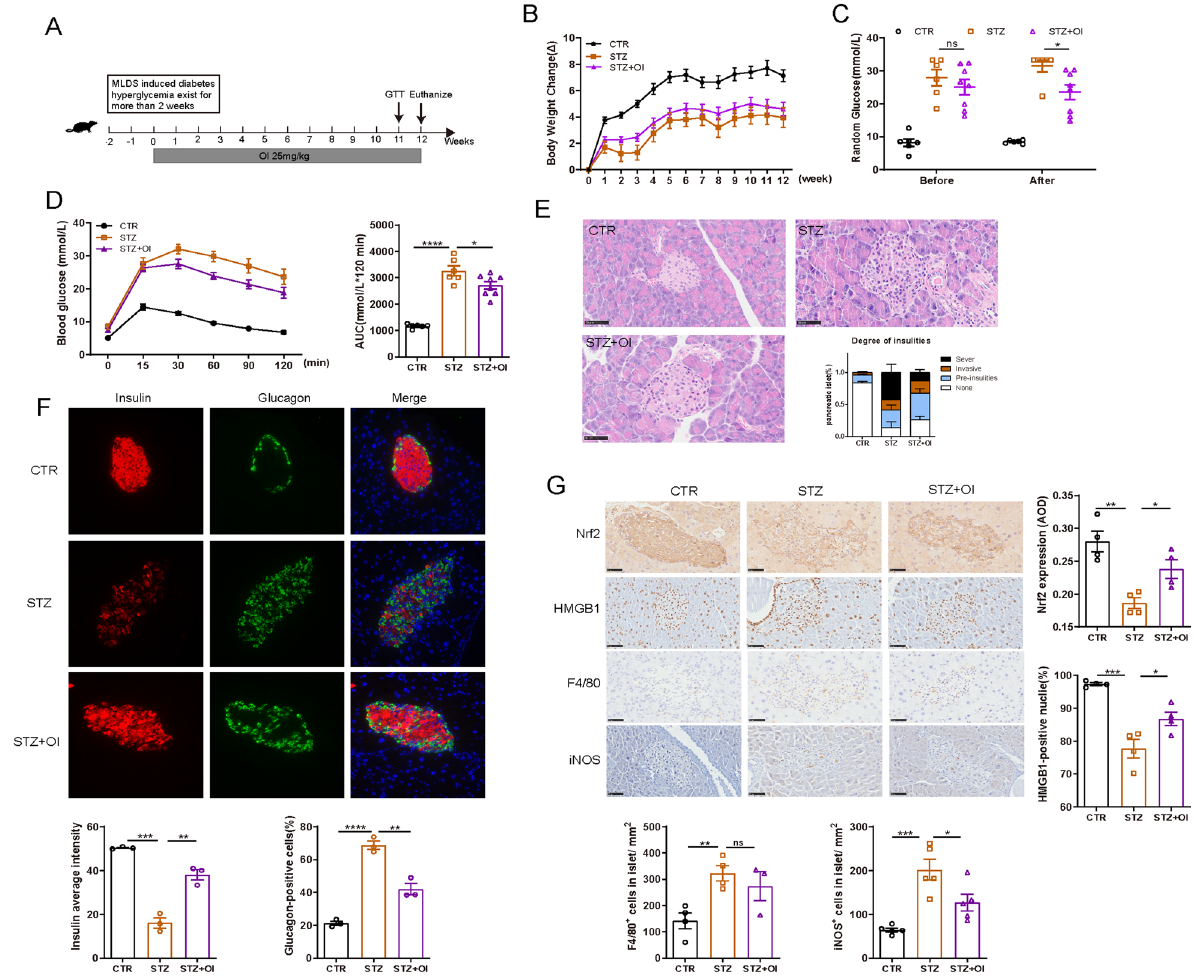
Fig. 4 The therapeutic effect of OI on glucose homeostasis and inflammation in STZ-induced diabetes. A Schematic representation of the experimental protocol. C57BL/6 mice with STZ-induced diabetes received OI (25 mg/kg) daily after hyperglycemia onset and for 12 weeks. B Mouse body weight change ( n 6–9 mice per group). C Random blood glucose measurements were performed before the study and at the end = of OI treatment. D Week 11 OGTT results. E Representative images of pancreatic histology evaluated by H&E staining ( n 5–7 mice per group). F = Representative images of pancreatic immunofluorescence staining for insulin (red), glucagon (green), and DAPI (blue). Insulin expression per islet was determined by analyzing fluorescence intensity with ImageJ. The percentage of glucagon-positive cells per islet was calculated in a bar graph ( n 3 mice per group). G Immunohistochemistry analysis of Nrf2, HMGB1, F4/80, and iNOS expression in mouse pancreas. Nrf2 expression was = analyzed by ImageJ and presented as the AOD. The percentage of HMGB1-positive nuclei per islet was quantified in a bar graph. The F4/80- and iNOS-positive cells per islet area were calculated in a bar graph ( n 3–5 mice per group). All values are shown as the mean SEM. ** p < 0.01, = ± *** p < 0.001, and **** p <